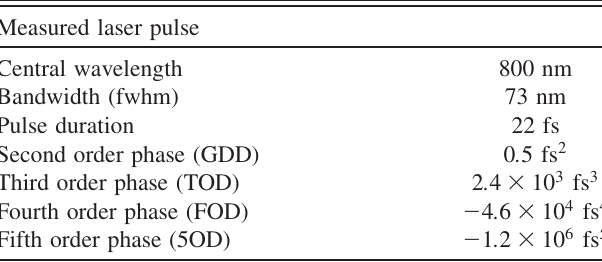
TABLE I. Measured parameters for a nearly transform-limited 800 nm pulse. The fourth order phase dominates the FEL performance.